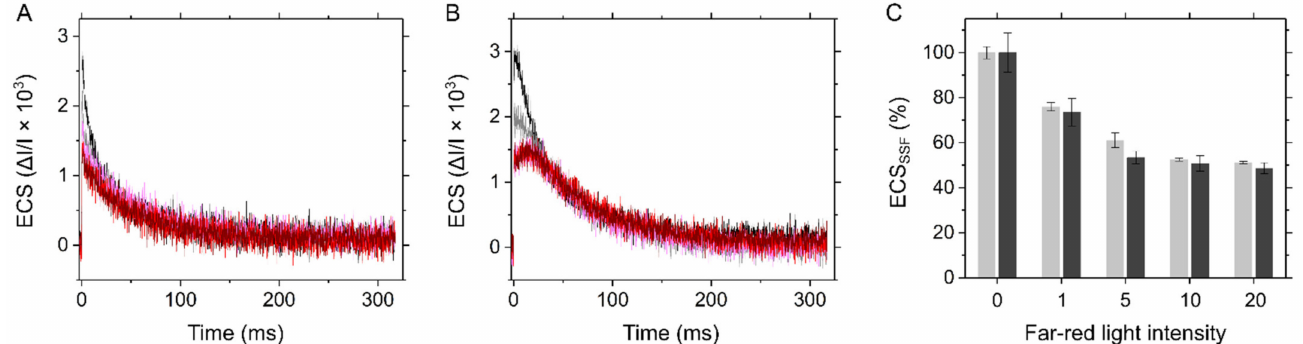
Figure 9. Electrochromic shift induced by a 5 µ s-short saturation flash (ECS SSF ) during far-red light illumination in the C 3 plant mustard ( A ) and the C 4 plant maize ( B ). Far-red light was provided at various intensities (0, black; 1, grey; 5, pink; 10, red; and the maximum 20, wine red; the values defined by the Walz software). ( C ) The flash-induced ECS changes normalized by the values without far-red light illumination as 100%. The data of mustard (light grey) and maize (dark grey) are shown as the mean with the standard deviation ( n = 3, biological